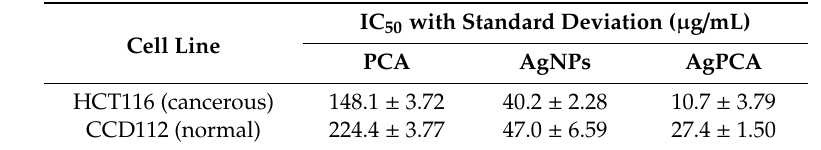
Table 2. IC 50 values of protocatechuic acid (PCA), silver nanoparticles (AgNPs) and PCA loaded AgNPs (AgPCA) against two cell lines.